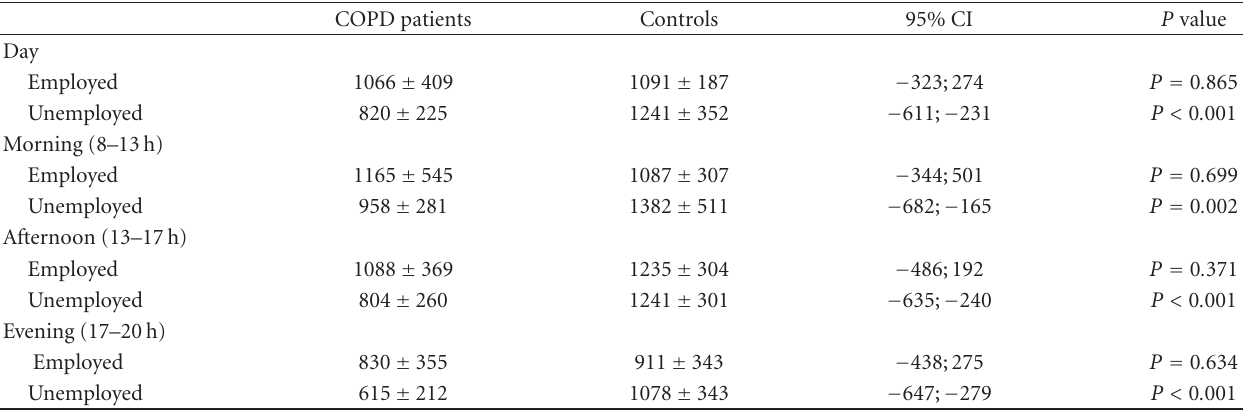
Table 2: Mean daily activity in counts per minute in COPD patients ( n = 39) and controls ( n = 21), stratified for employment status (COPD: employed ( n = 7)/unemployed ( n = 32), controls: employed ( n = 11)/unemployed ( n = 10)). COPD